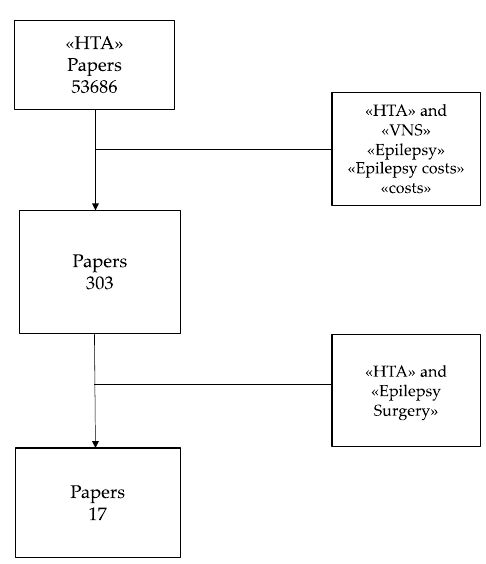
Figure 1. Literature search progression: (Health Technology Assessment: HTA).